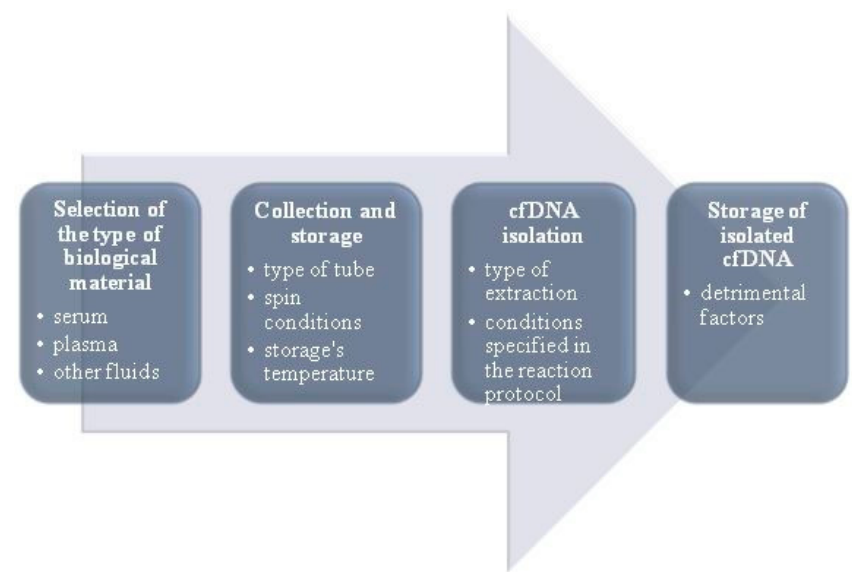
Figure 2. Pre-analytical stages to optimise the extraction process (modified based on Bronkhorst et al. [37]).